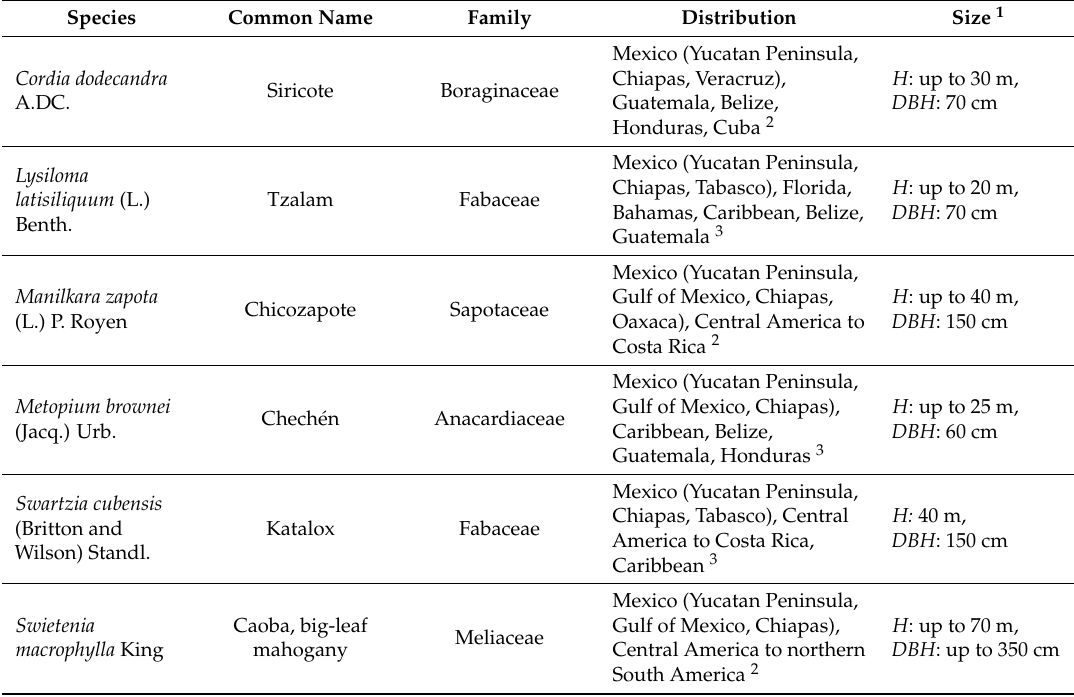
Table 1. Species studied, their common names, taxonomic families, distributions, and height ( H ) and diameter at breast height ( DBH ) reported in the